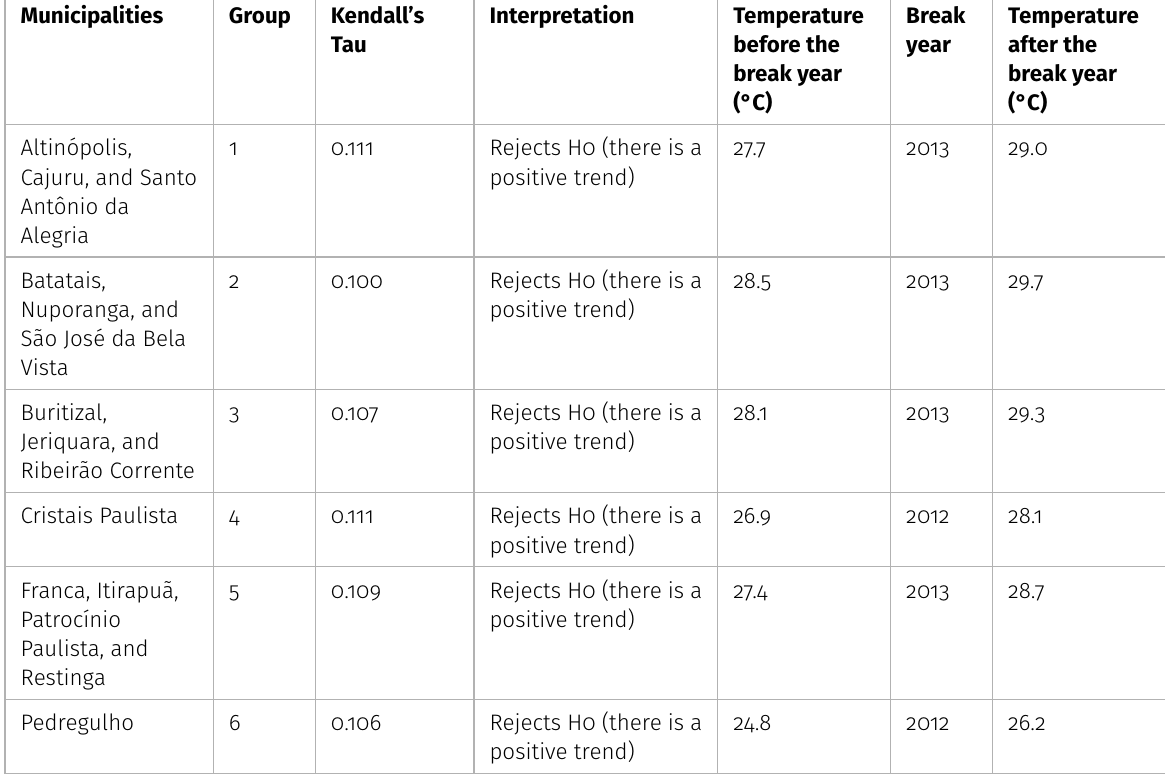
Table I. Mann-Kendall test and Pettitt test values for maximum